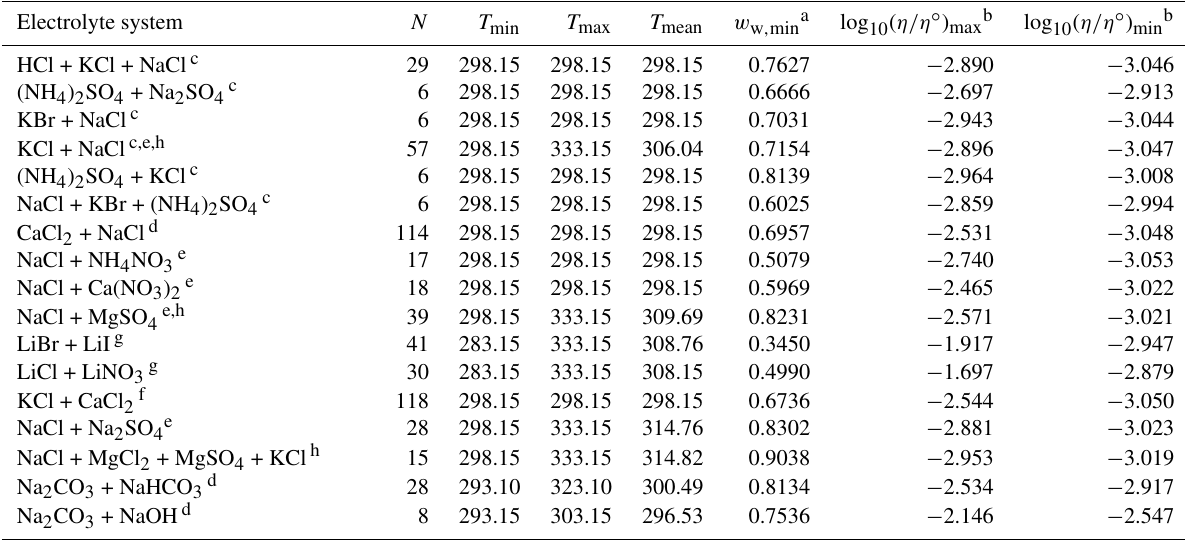
Table 4. Data set information for bulk measurements of ternary and quaternary aqueous electrolyte mixtures used to fit the AIOMFAC-VISC electrolyte model.